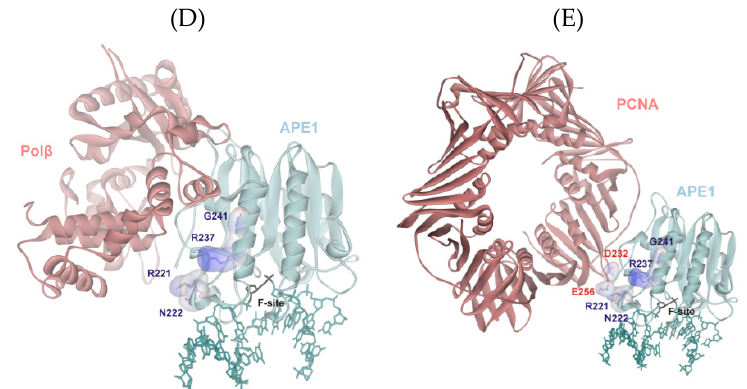
Figure 5. Possible amino acid interfaces participating in the protein–protein interactions around the area of a substituted amino acid residue in the SNP variants of APE1 as documented for OGG1 ( A ), AAG ( B ), UNG2 ( C ), Pol β ( D ), and PCNA ( E ). Surface amino acid residues of APE1 (Arg221, Asn222, Arg237, and Gly241) and amino acid residues of the effector proteins, if any, that were found near the SNP-induced substitutions in APE1 are illustrated in the transparent view of the electrostatic potential.